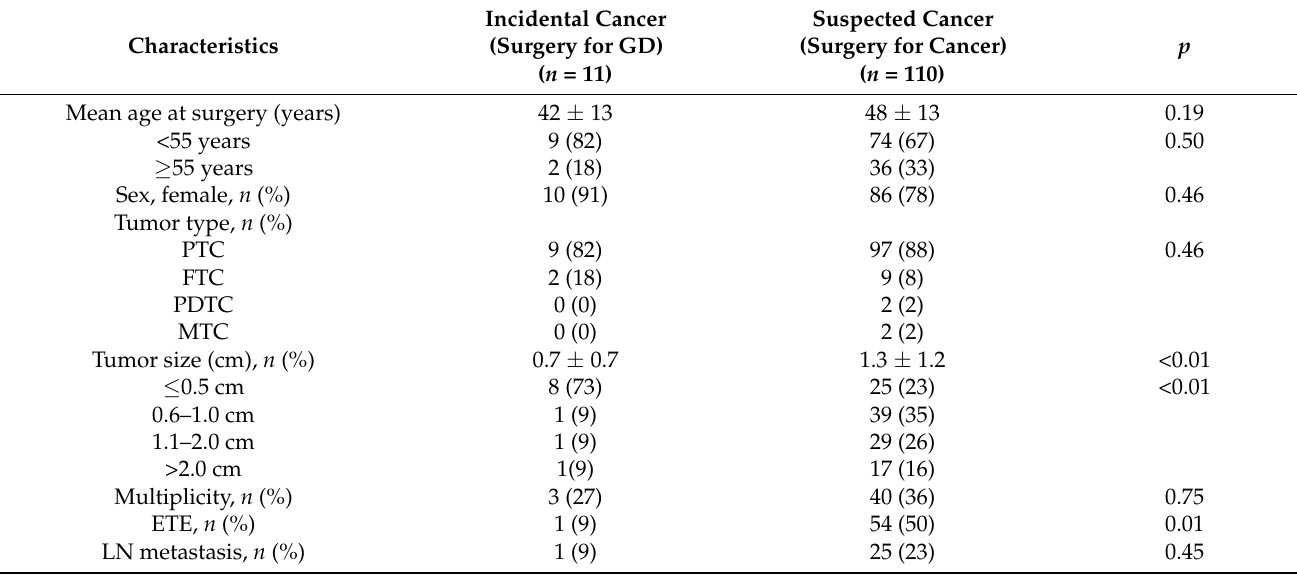
Table 3. Comparison of cancer characteristics between incidentally found thyroid cancer after surgery and thyroid cancer suspected before